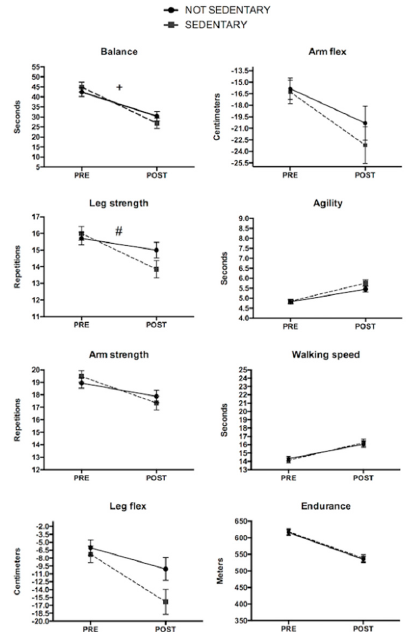
Figure 3. Fitness changes according to sitting time (ST) during the follow-up in males. # Significant group-by-time interaction. + Trend towards significant group-by-time interaction ( p = 0.061). Both groups showed a significant decrease from baseline to follow-up ( p < 0.05), except for the leg strength of the NOT-SEDENTARY group.